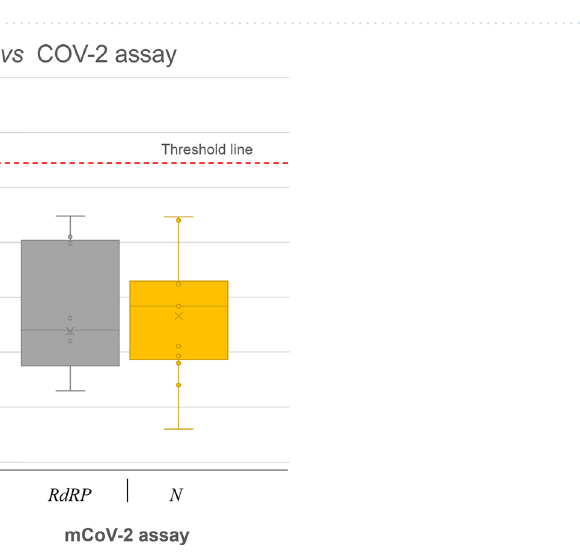
Figure 2. Standard curve analysis for multiplex rRT-PCR of ( a ) RdRP and ( b ) N primers. The template RNA was serially diluted with a range of 10 5 to 10 1 . The reactions were carried out in triplicate. The amplification efficiencies (E) were shown on each graph. The error bars represent the standard deviation between the replicates. The error bars represent the standard deviation between the replicates. The amplification plots are shown in Supplementary Fig. S2.